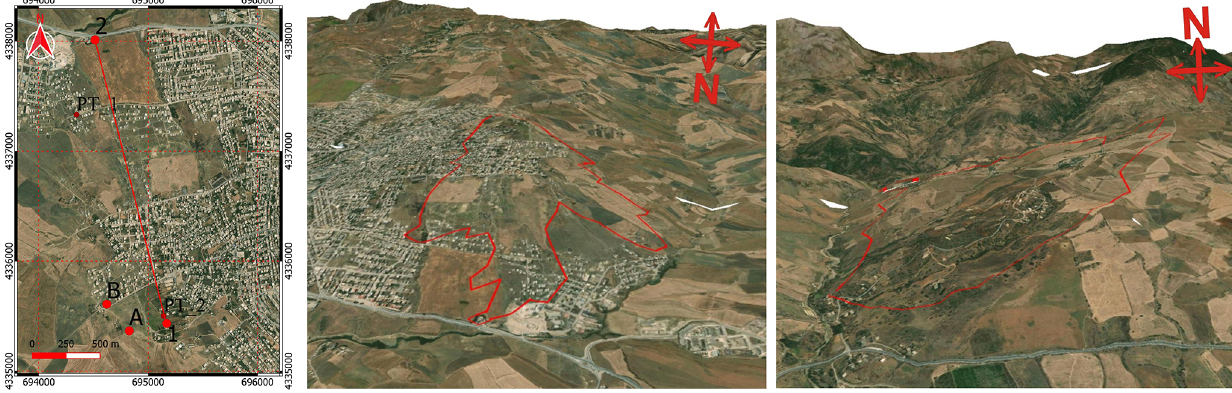
Figure 2. The 3D view of AoIs, Kherba AoI, and Grarem using QGIS with DEM SRTM 1sec and ESRI basemap. Panels (a, b) show the Kherba AoI, and (c) shows the Grarem case area. The red polygon is the boundary of change detected by